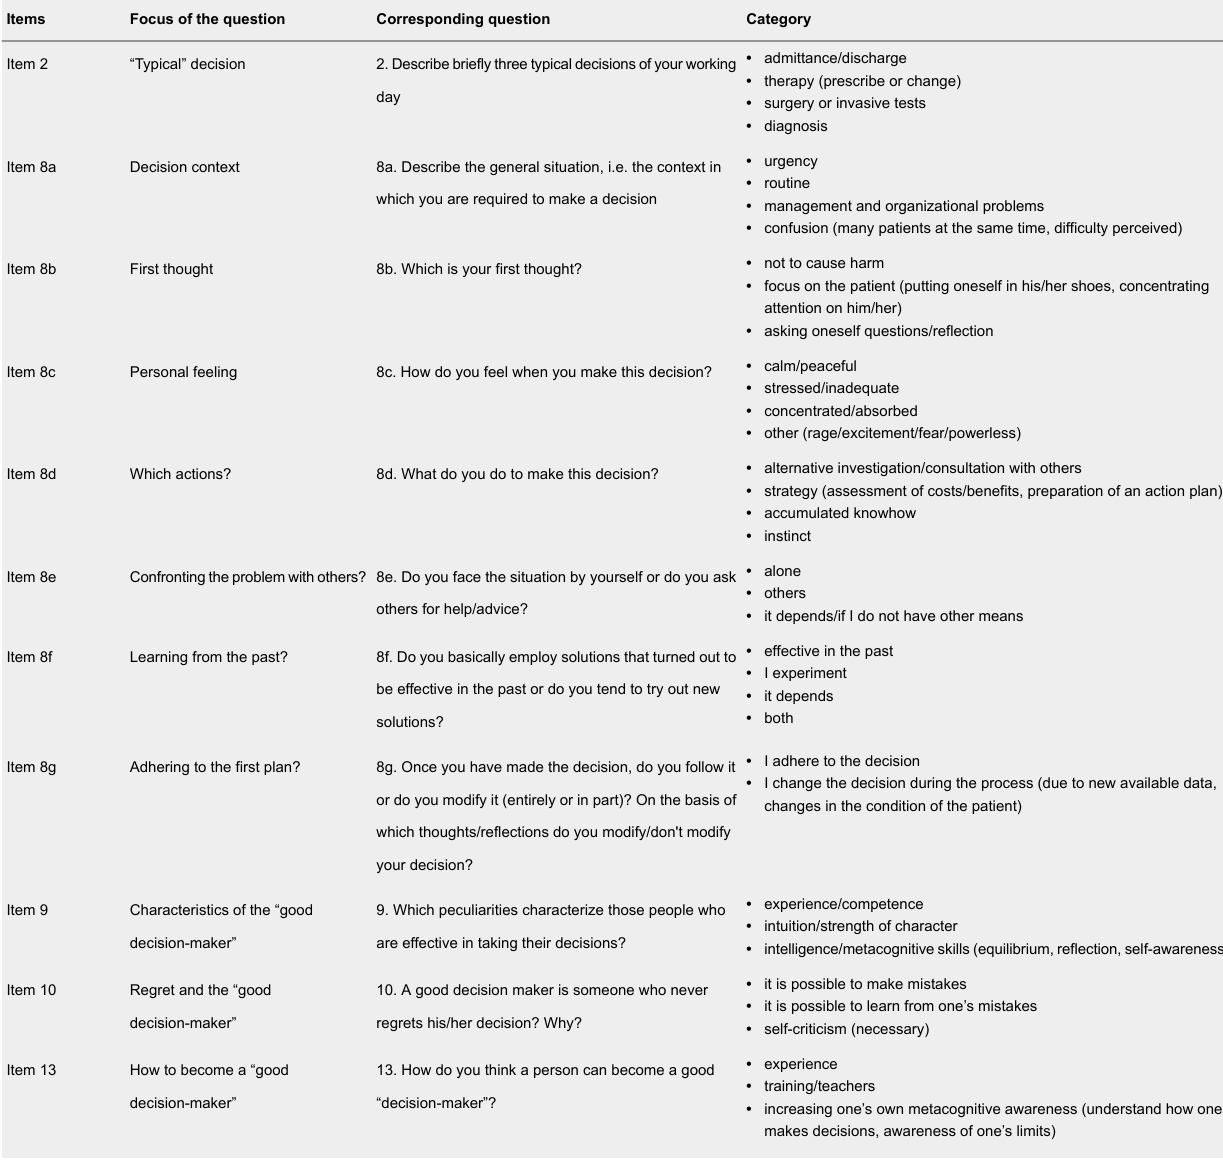
Semantic Category System for Coding Questionnaire Responses